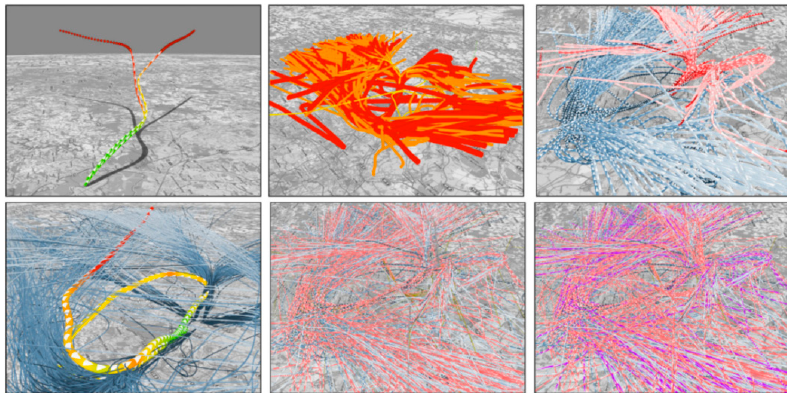
Figure 2. Interactive visualizations based on geometric icons [3].